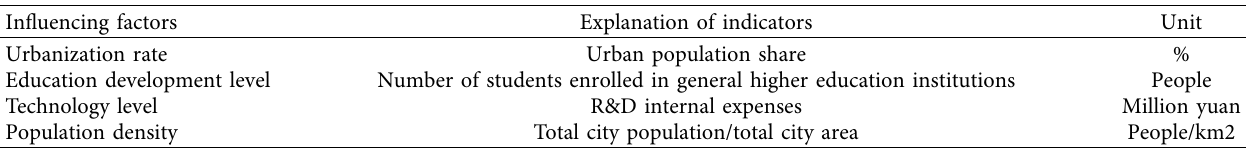
Figure 4: Spatial pattern of logistics industry, economic development level, and cold and hot spots of coupling and coordination of the two systems in the Central Plains City Cluster. Table 5: Influencing factor index